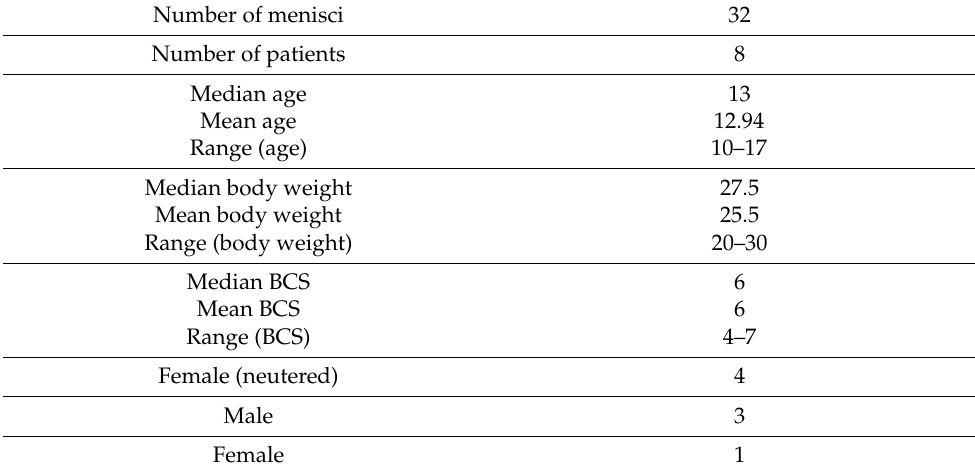
Table 1. Information about study population.